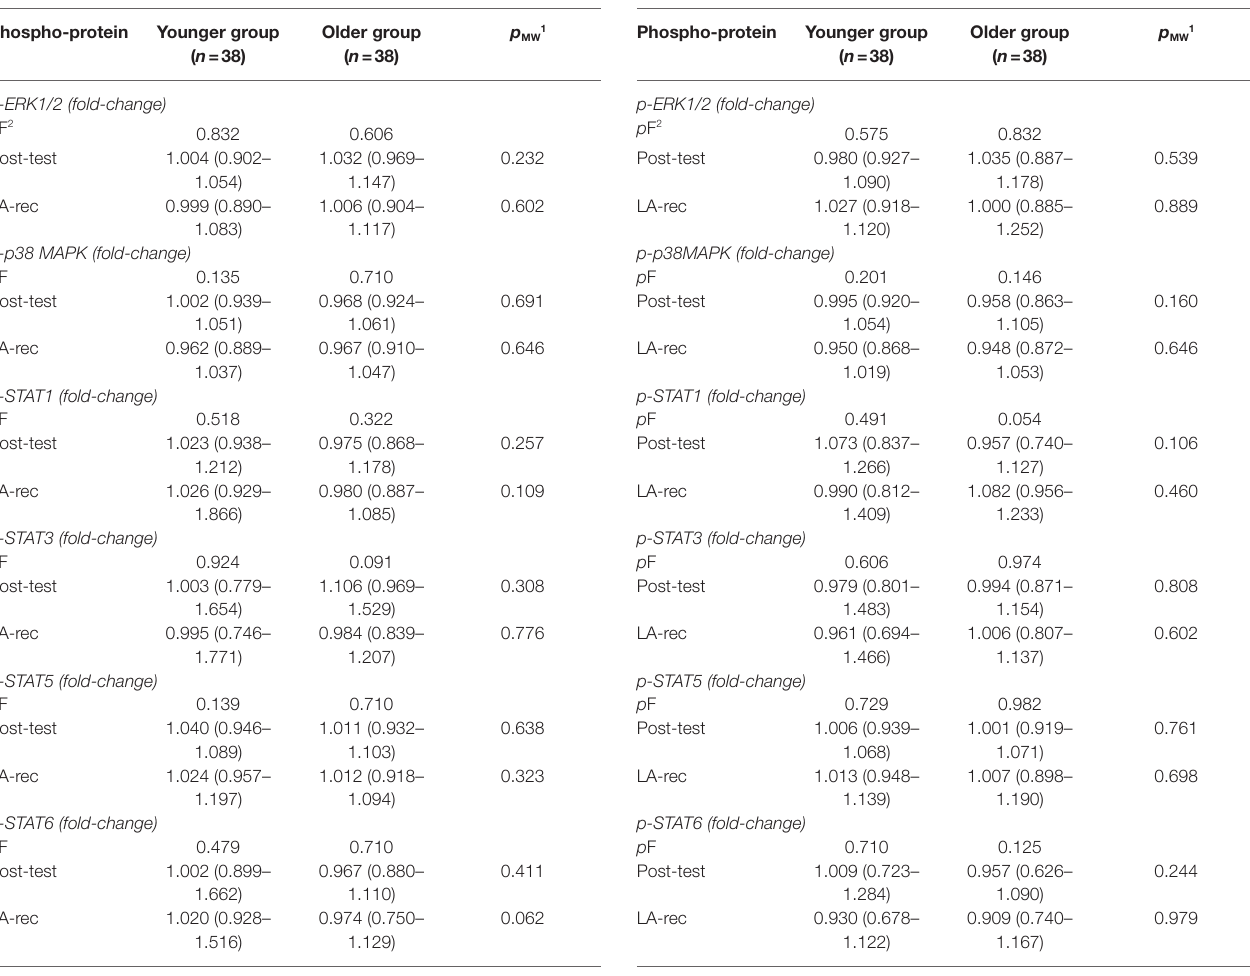
TABLE 7 | The changes in calculated values of median fluorescence intensity (MFI) measuring phosphorylation level of analyzed proteins (p-ERK1/2,